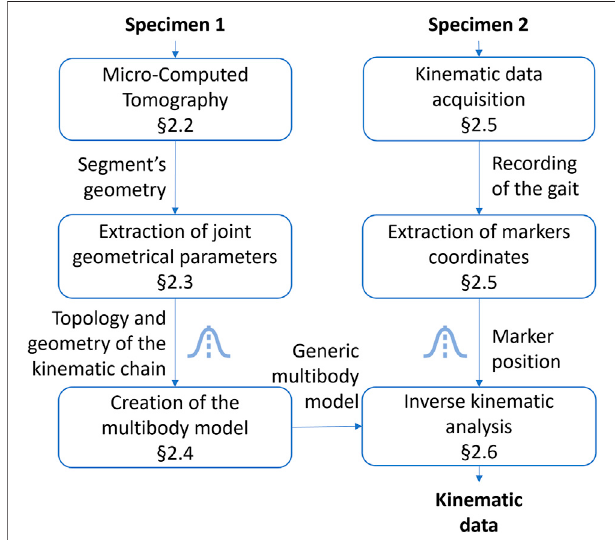
FIGURE 1 | Followed research methodology. The Gaussian distribution icon indicates model parameters subjected to